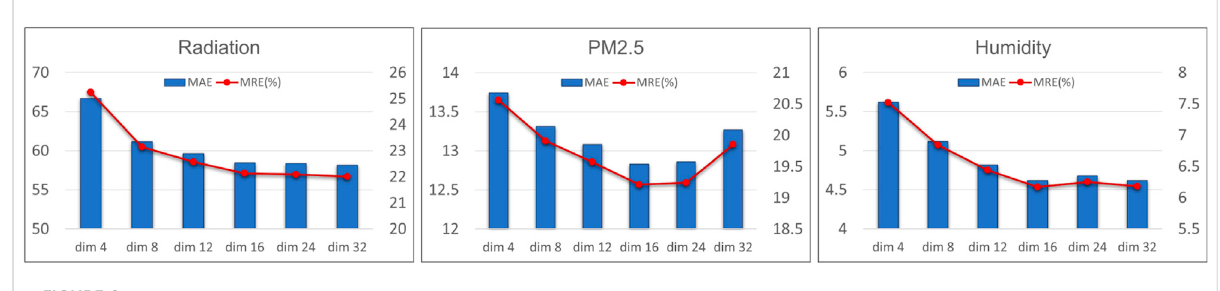
FIGURE 2 Study of varied embedding dimensions for constructing adaptive graphs on three